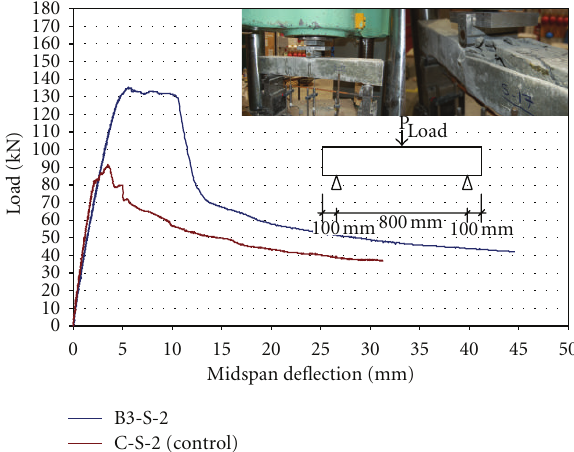
Figure 32: Load versus midspan deflection of RC beam B2-6B-NS- 3.